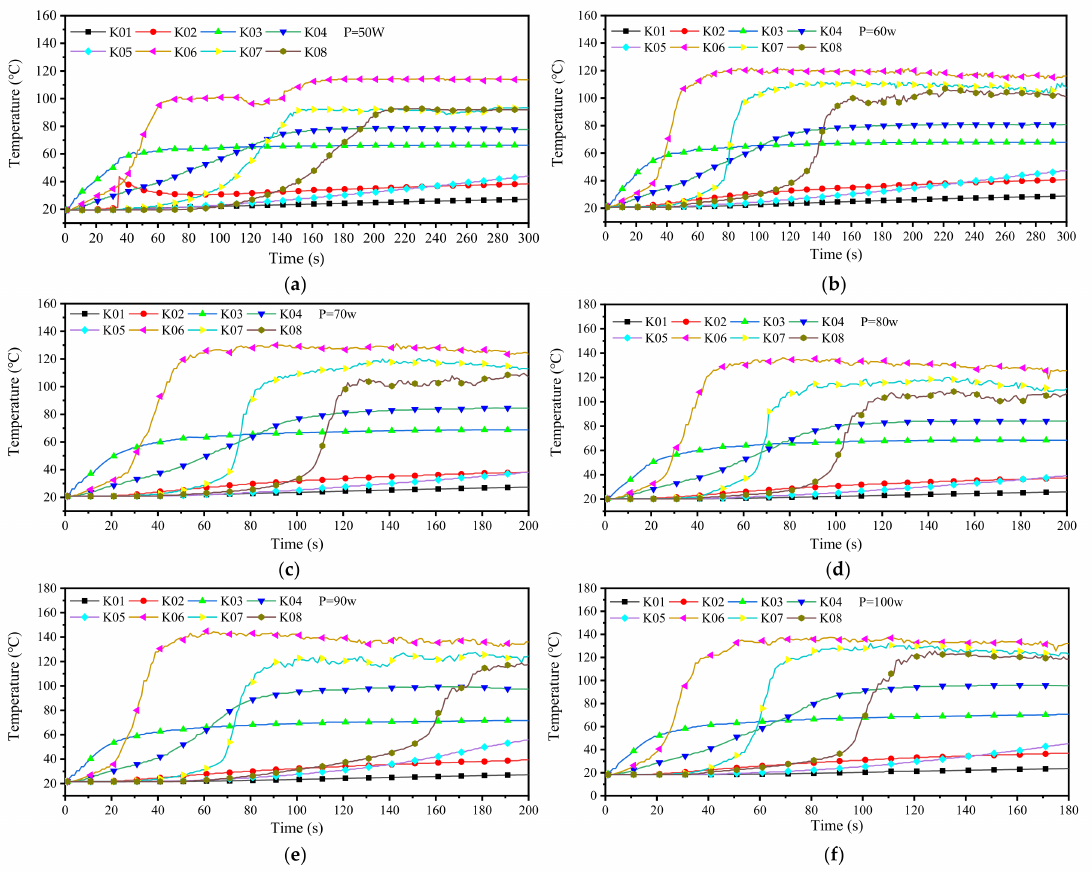
Figure 10. Monitoring the melting process of para ffi n: ( a – f ) the temperature of each position when the heating power is 50, 60, 70, 80, 90, and 100 w.